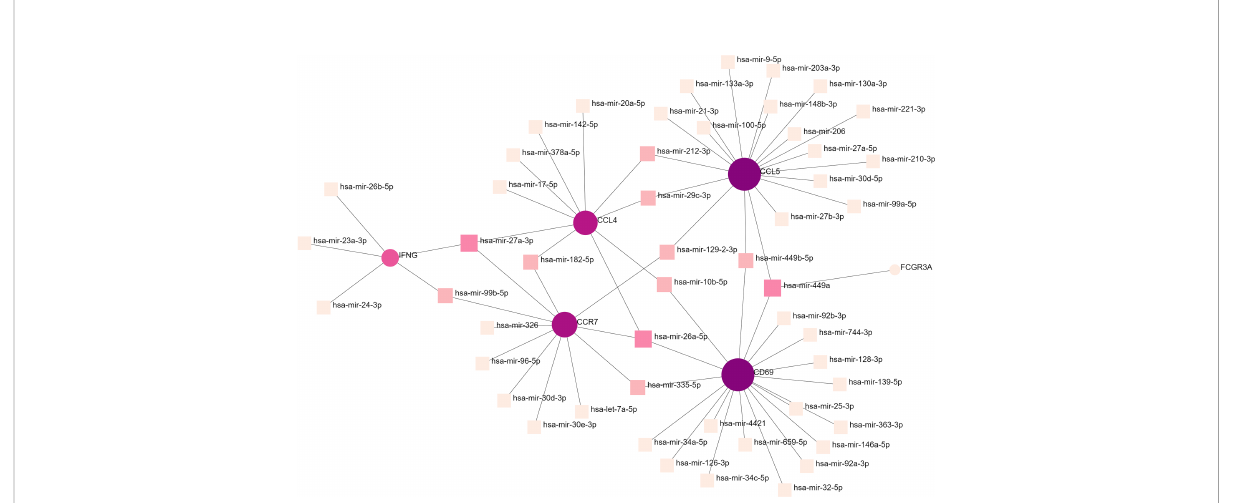
FIGURE 6 Gene – miRNA interaction network analysis. Round dots indicate hub genes; square dots indicate miRNAs. Darker colors indicate association with a greater number of hub genes and a higher degree of association. miRNA,